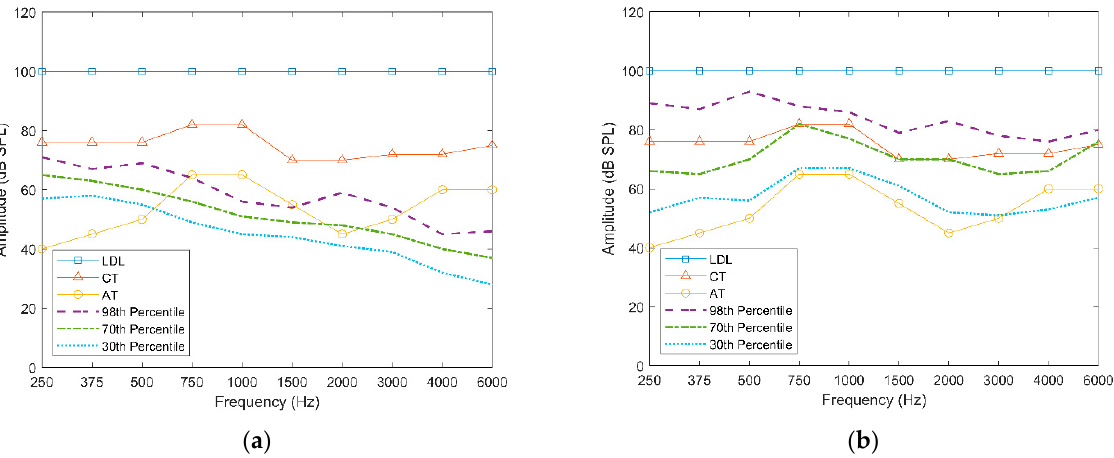
Figure 4. Sample hearing response of a subject: ( a ) SPL percentile distribution before applying ADRO, ( b ) SPL percentile distribution after applying ADRO.